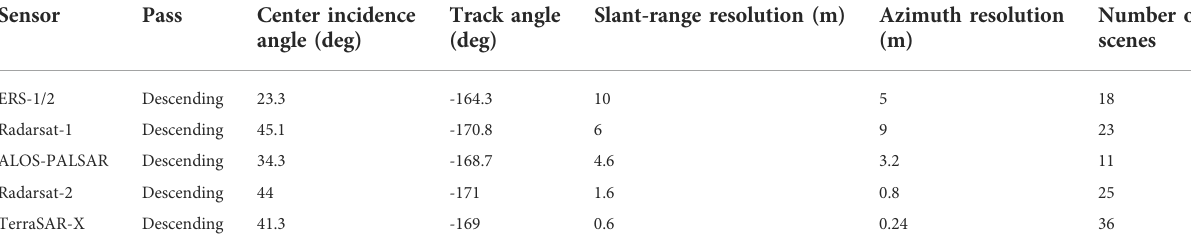
TABLE 1 InSAR data parameters and acquisition periods, June 1996 to September